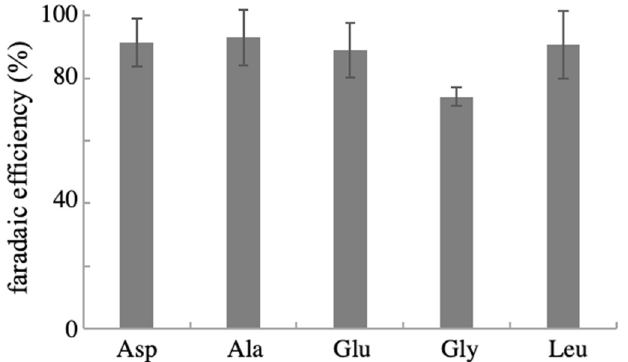
Figure 6. FE for the electrochemical conversion of α -keto acids with NH 2 OH to the corresponding amino acids using an NPG electrode. A solution containing 50 mM of α -keto acid and NH 2 OH was electrolyzed at − 0.01 V for 30 min. The FE values are presented as mean ± SD (n = 4 independent experiments).